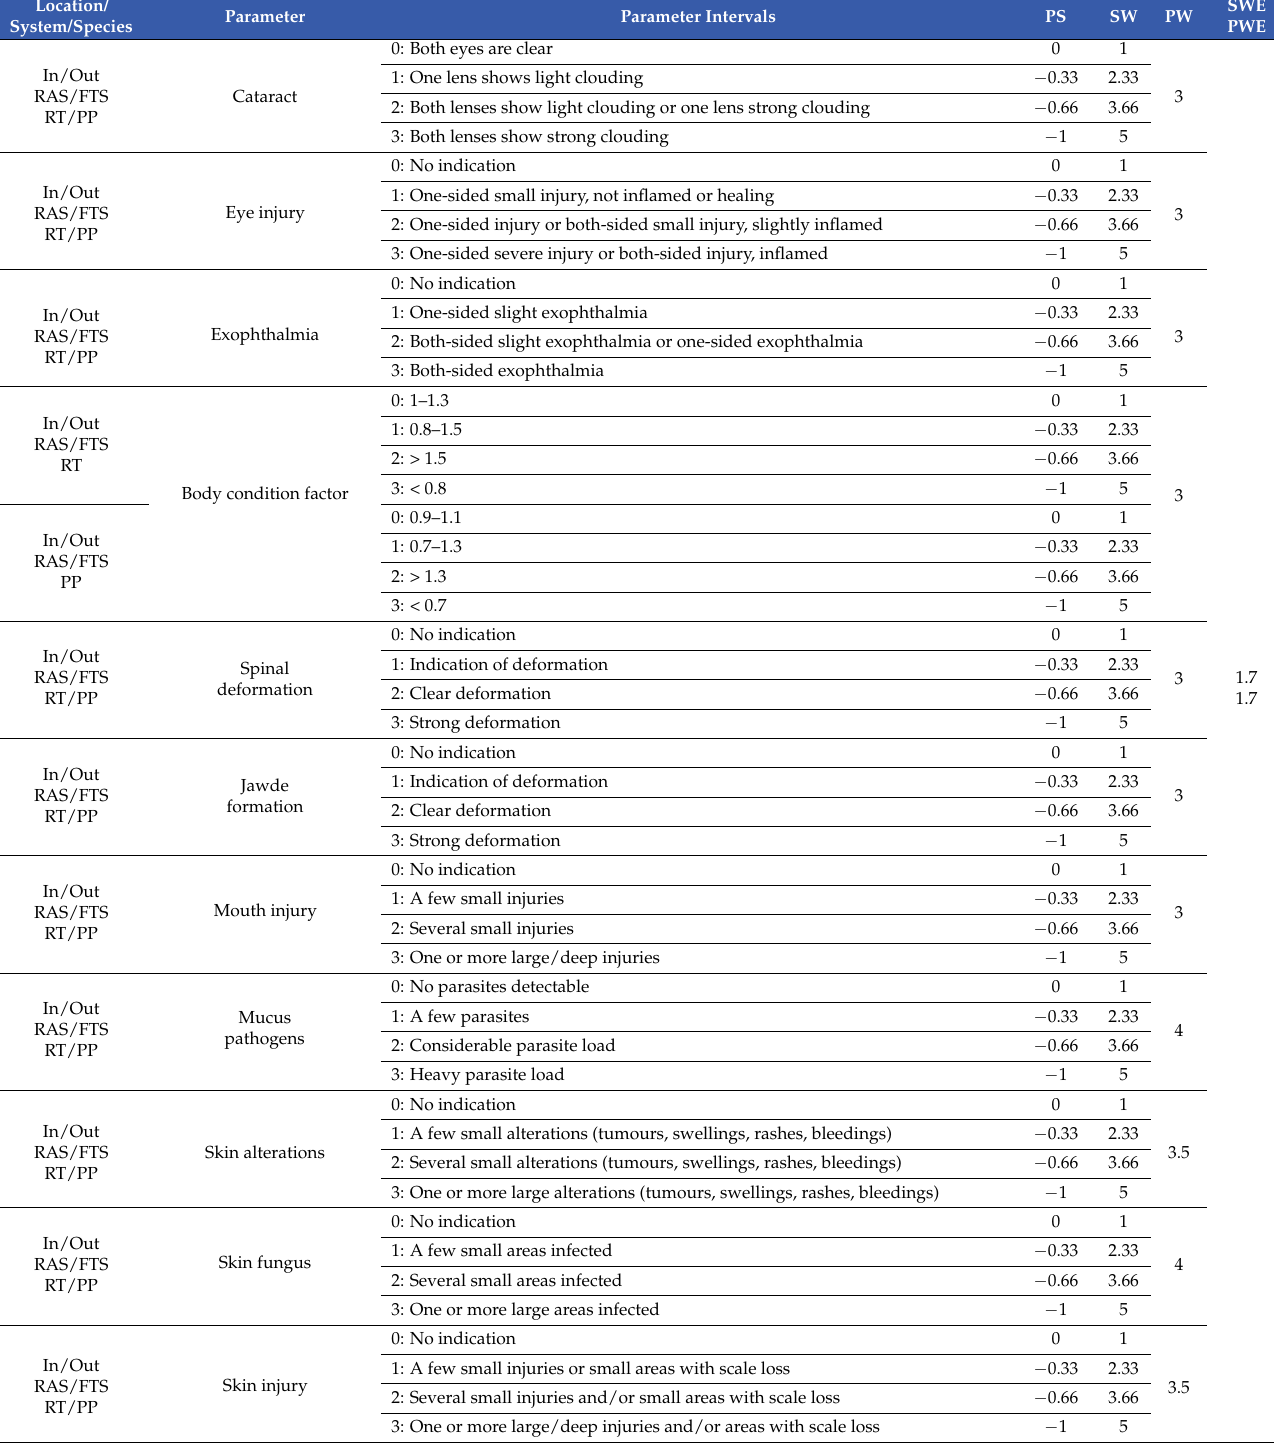
Table A5. Module fish external appearance (1/2). In = indoor, Out = outdoor, RAS = recirculating aquaculture system, FTS = flow-through system, RT = rainbow trout, PP = pikeperch, PS = parameter score, SW = score weight, PW = parameter weight, SWE = score weight exponent, PWE = parameter weight